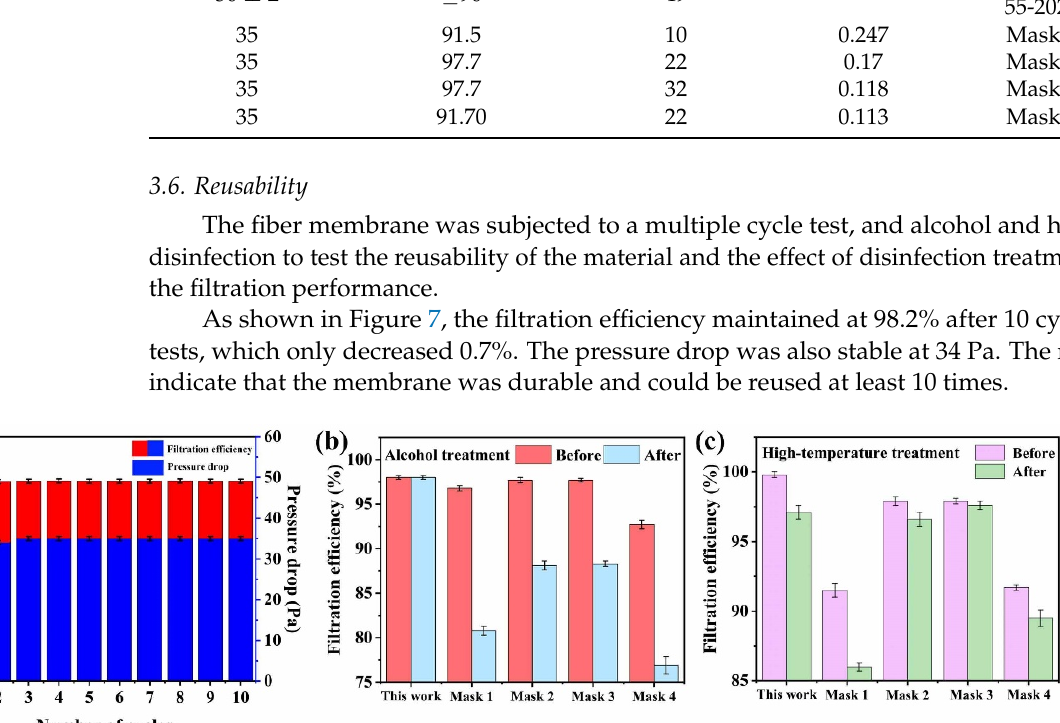
Table 1. Comparison of filtration performance between CA/TPU ‐ 1LiCl fiber membrane and related mask standards and commercial masks.